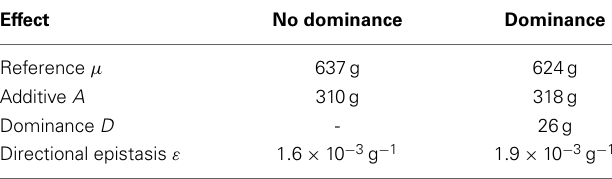
Table 1 | Epistatic line-cross analysis of the chicken